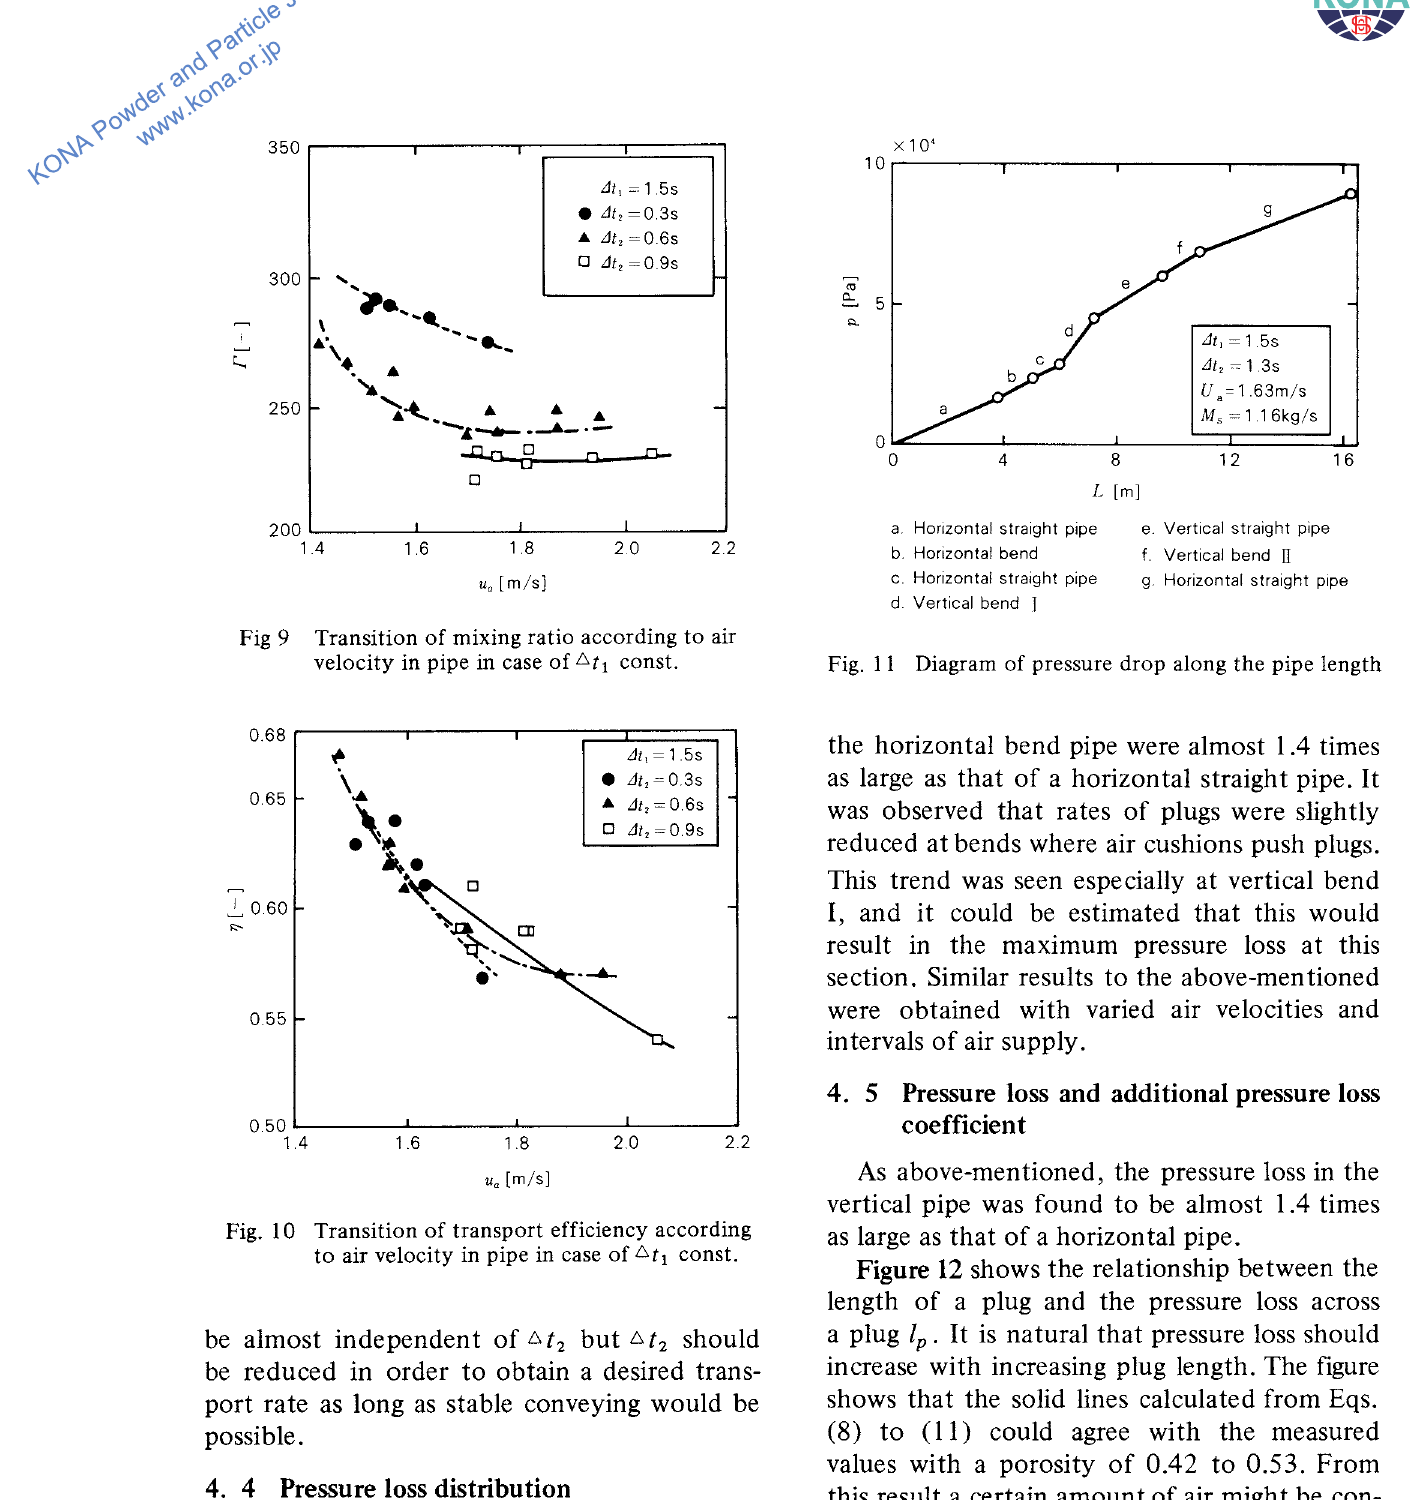
Fig. 1 0 Transition of transport efficiency according to air velocity in pipe in case of Lit 1 const.